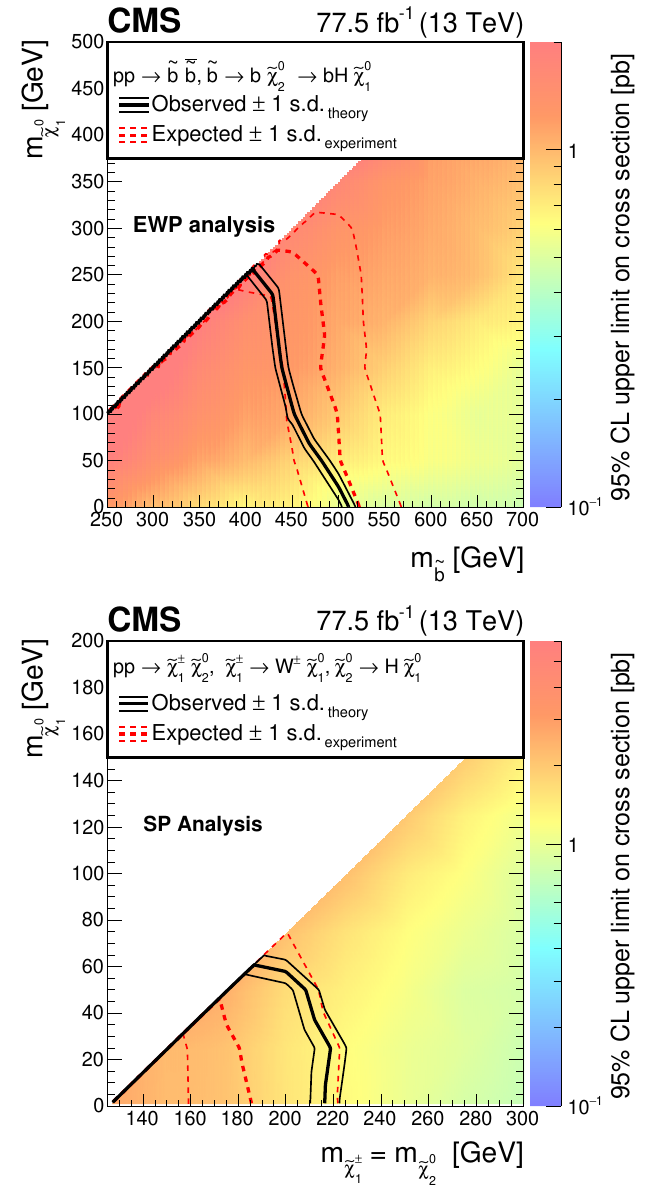
Figure 6 . The observed 95% CL upper limits on the bottom squark pair production cross section for the EWP analysis (upper plot), and on the wino-like chargino-neutralino production cross section for the SP analysis (lower plot), are shown. The bold and light solid black contours represent the observed exclusion region and the (cid:6) 1 standard deviation (s.d.) band, including both experimental and theoretical uncertainties. The analogous red dotted contours represent the expected exclusion region and its (cid:6) 1 s.d. band.